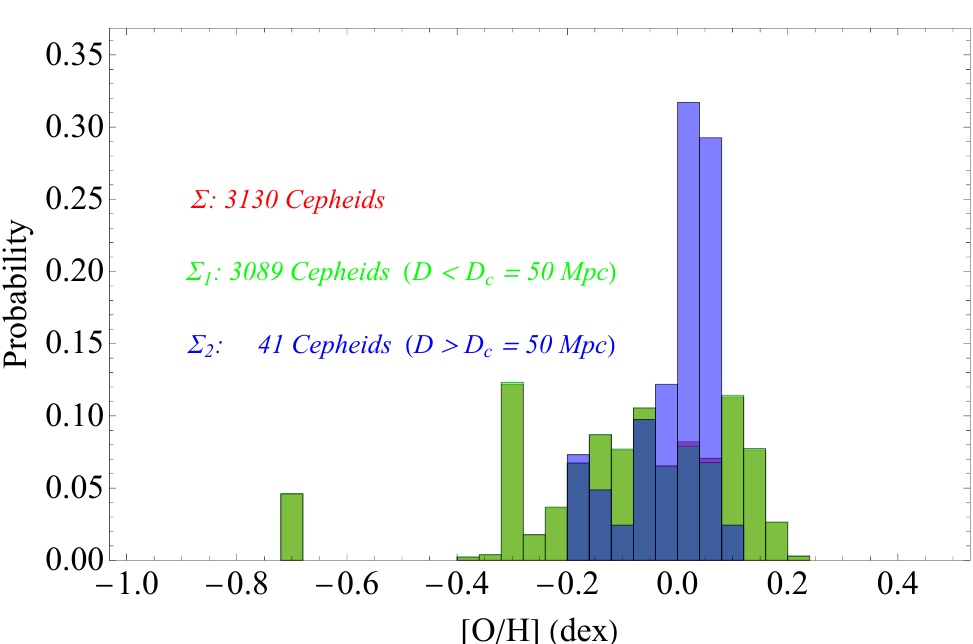
Figure 7. Probability distributions of the Cepheid metallicity for the whole Cepheid sample and for the high ( D > D c ) and low distance ( D < D c ) subsamples for D c = 50 Mpc. Due to the small number of Cepheids in the D > 50 Mpc bin (41), the probability distribution of the full sample (3130 Cepheids) is almost identical to the probability distribution of the D < 50 Mpc bin, and thus the light green bars overlap with the red